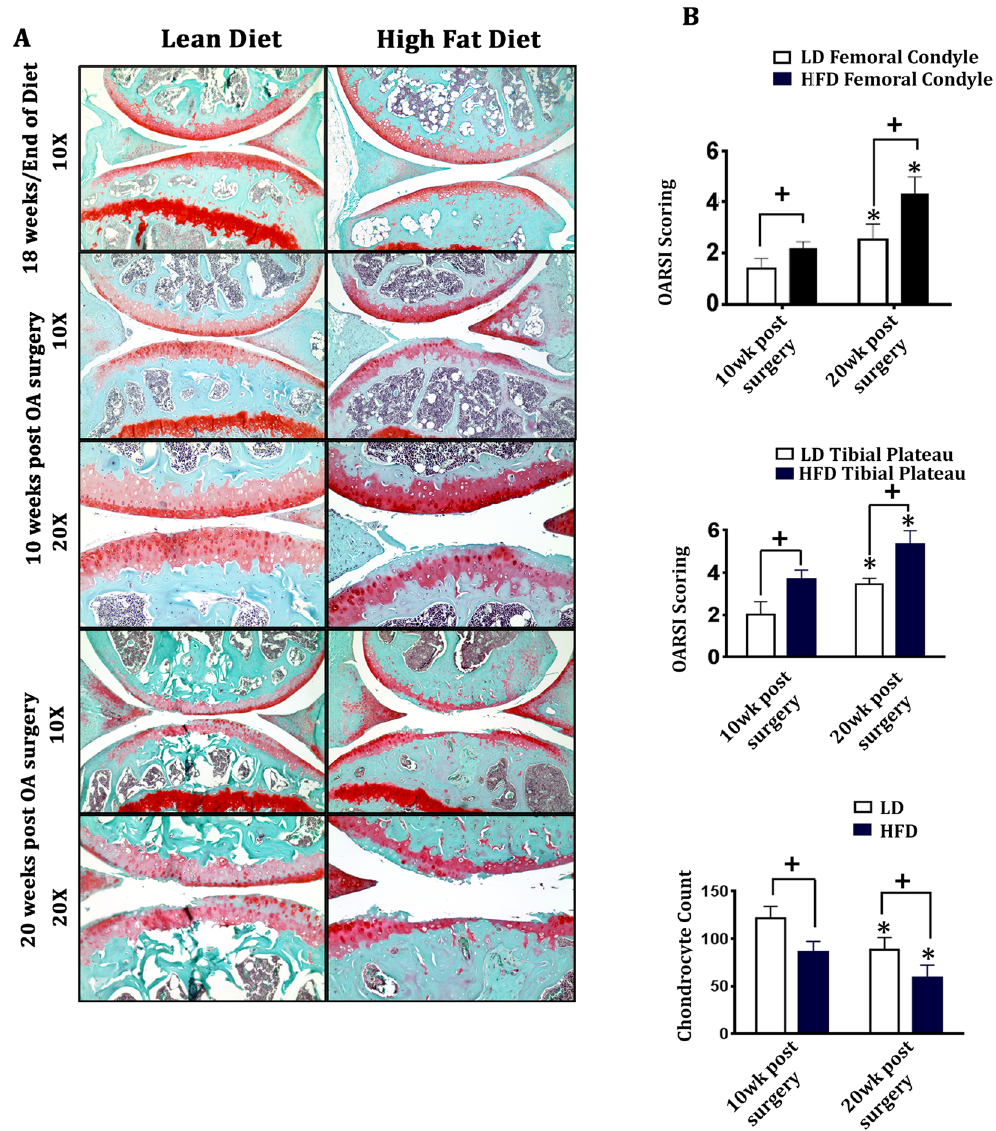
Figure 2. High fat diet-fed mice exhibit accelerated surgically-induced OA. ( A ) Representative histological images of Safranin-O/Fast Green stained knee joint sections from lean diet (LD) and high fat diet (HFD)- fed mice that underwent destabilisation of medial meniscus (DMM surgery) at 18 weeks of diet (6 months of age) and were collected at 10 or 20-weeks post-surgery. Magnification is 10x and 20x. ( B ) Severity of OA pathogenesis was determined by OARSI histopathology grading of mouse femoral condyles and tibial plateaus, and number of chondrocytes per area were counted. Data were analysed by Two-way ANOVA followed by Holm-Sidak multiple comparison tests. Data are expressed as mean ± SD (n = 10). + p < 0.05, LD vs HFD at 10- weeks or LD vs HFD 20-weeks post-surgery. * p < 0.05, HFD at 10-weeks vs HFD at 20-weeks of post-surgery or LD at 10 weeks vs LD 20 weeks of